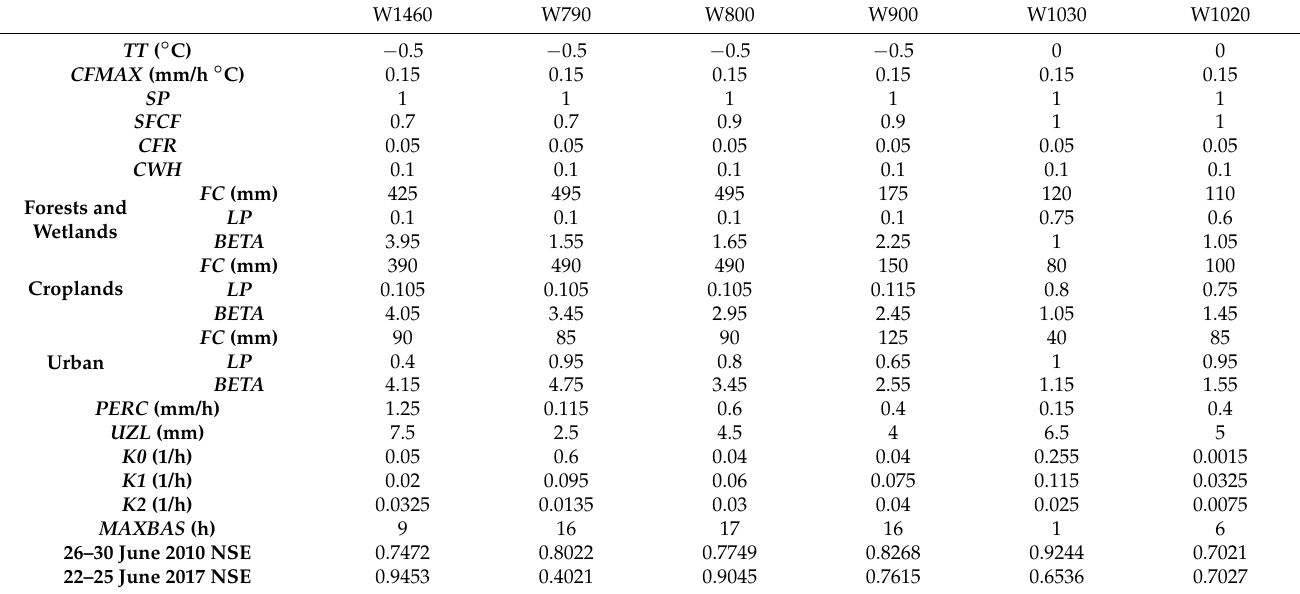
Table 15. Optimal values’ parameters via calibration of the HBV-light model for the events of 26–30 June 2010 and 22–25 June 2017.